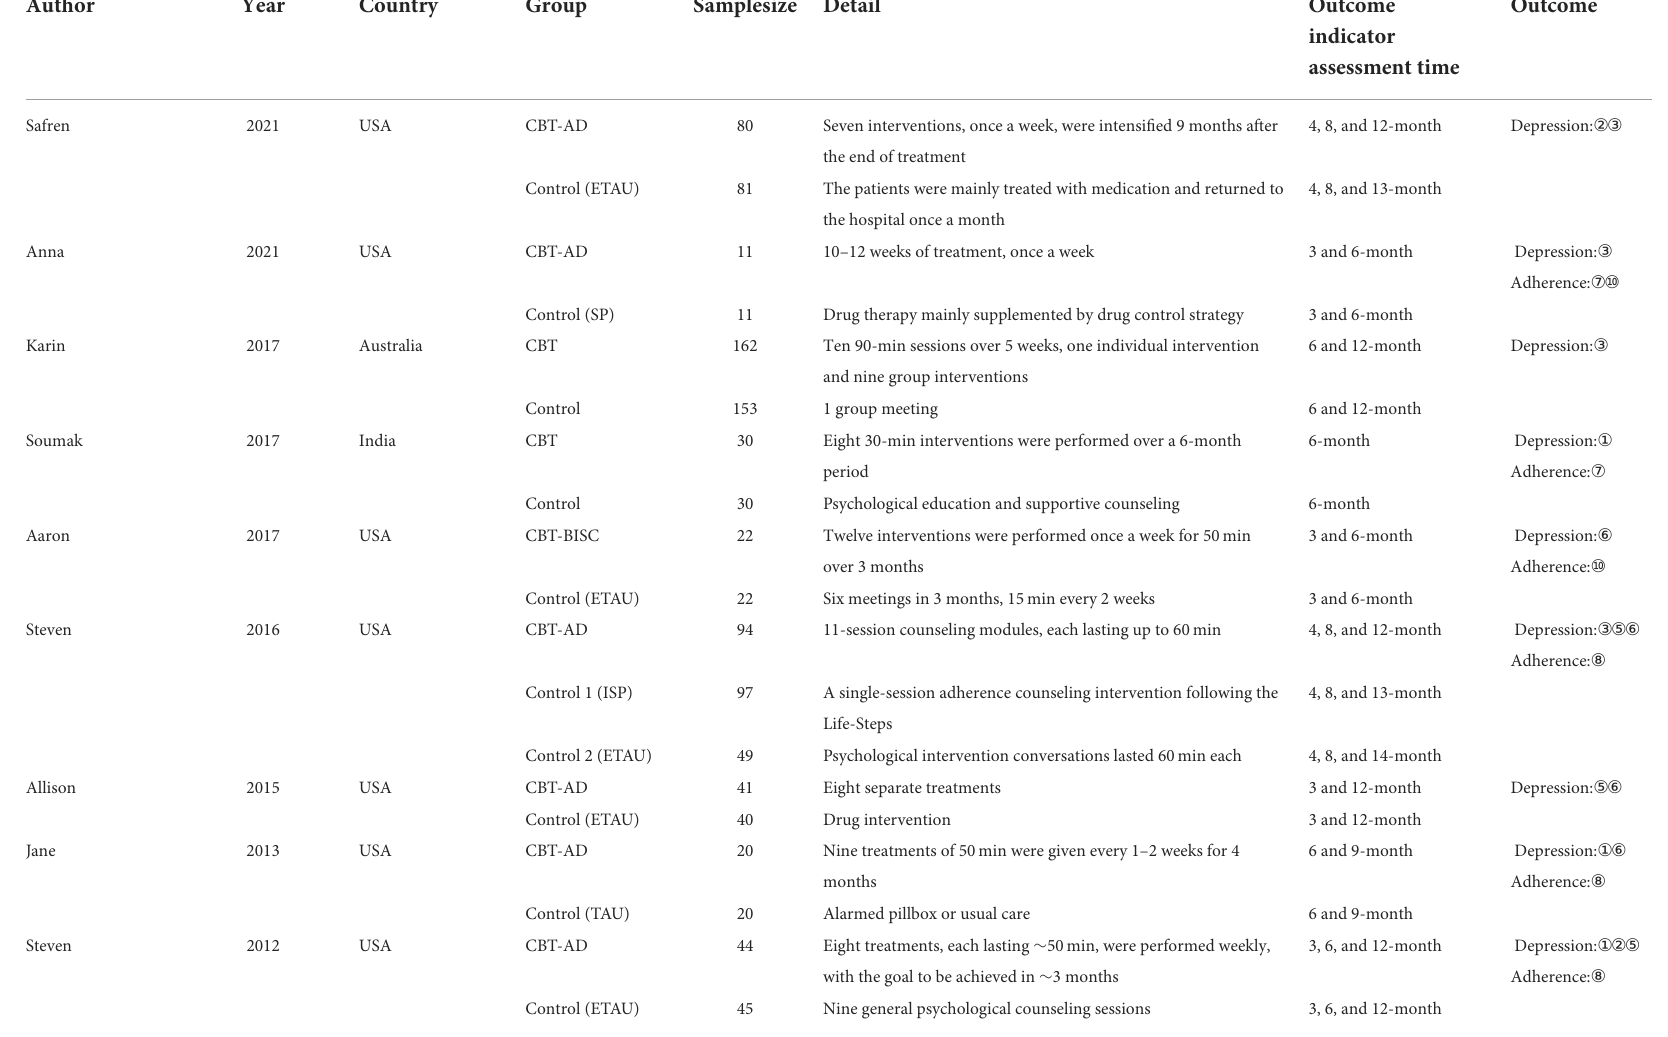
TABLE 1 Basic characteristics of included